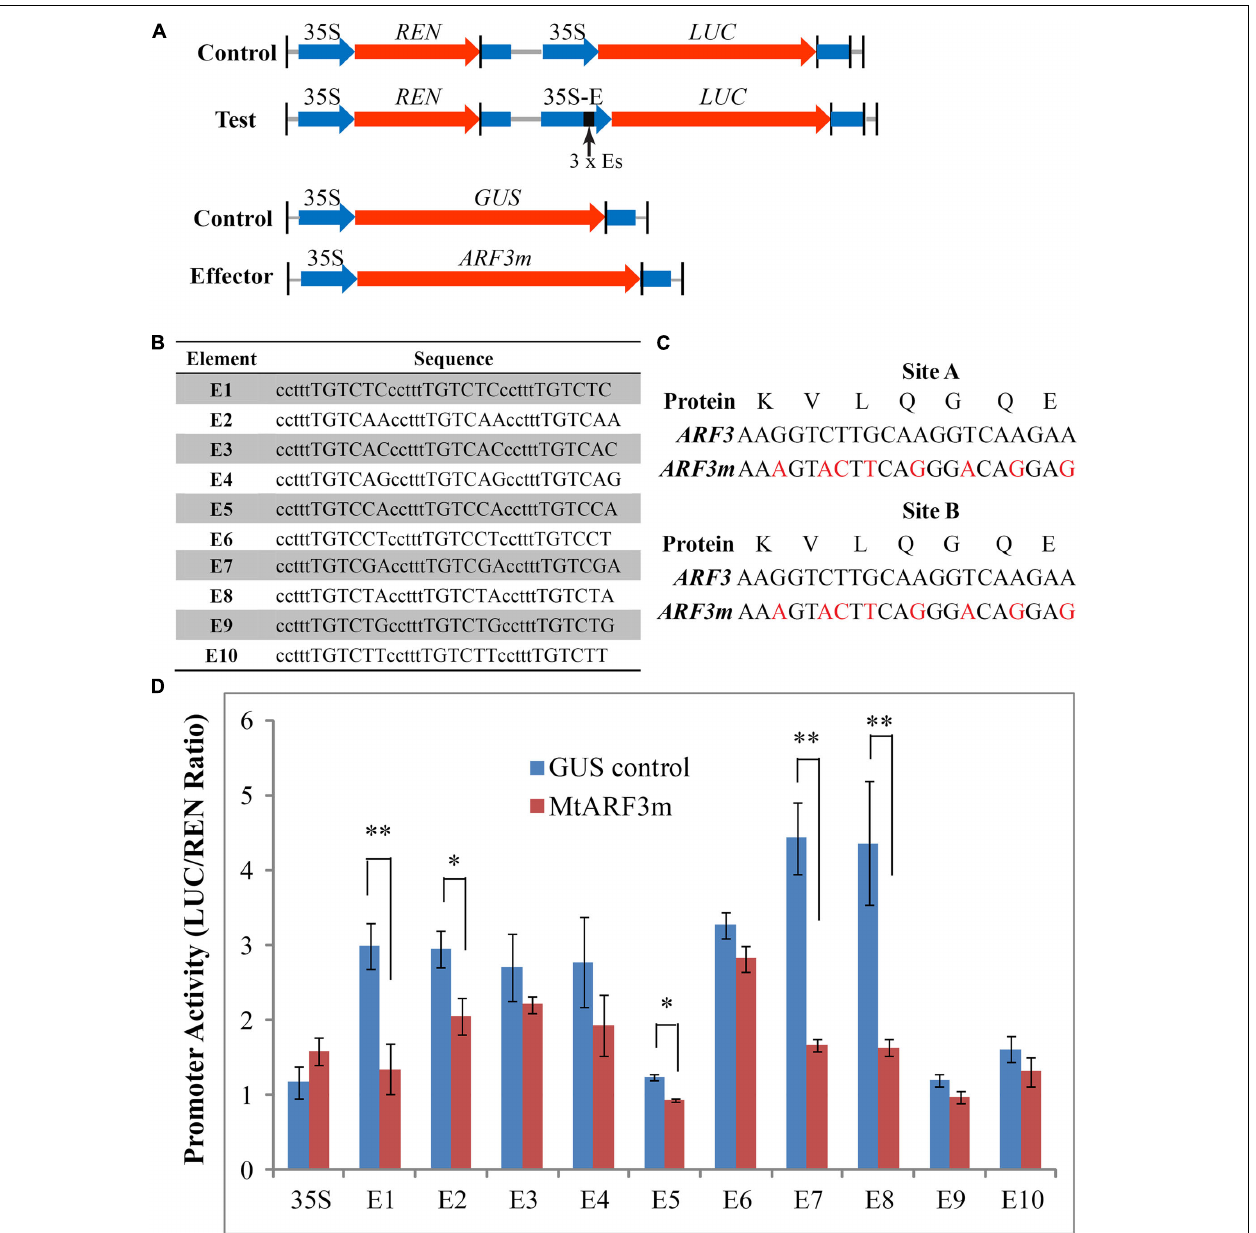
FIGURE 2 | Transcription activity assays in tobacco leaves. (A) Schematic drawings of reporter and effector constructs used in quantitative luciferase activity assays in tobacco leaves. (B) Putative AuxRE sequences in the PALM1 promoter region were tested. Capital letters denote the cis -elements and lower case letters denote the spacer between cis -element repeats. (C) Construction of tasiR - ARF -resistant MtARF3 m . Red letters denote synonymous mutations to disrupt tasiR - ARF recognition sites A and B. (D) Luciferase activity assays in tobacco leaves. Firefly luciferase (LUC) activities were normalized against Renillia luciferase (REN) activities. Shown are means ± SD; n > 6. Student’s t -test, ∗ p < 0.05; Student’s t -test, ∗∗ p <